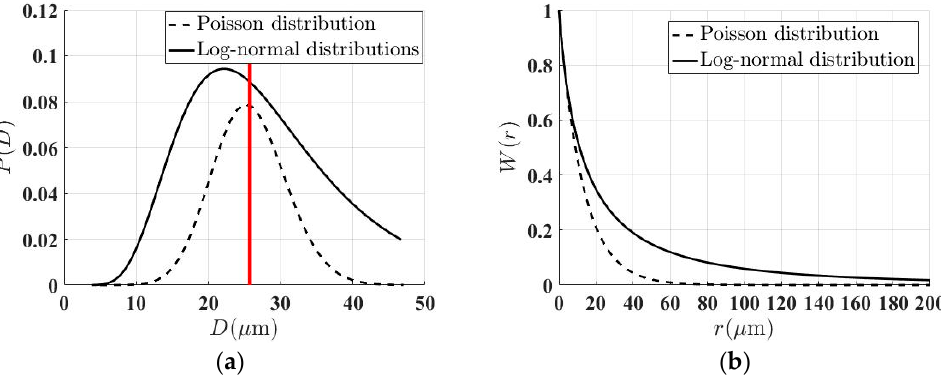
Figure 9. Comparison in ( a ) the probability density function of grain-size P ( D ) , and ( b ) the spatial correlation function W ( r ) between the assumed Poisson statistics in the classical model by Rokhlin and the log-normal distribution model fitted for the specimen holding for 0.5 h with a mean grain size of D = 26 µ m. (Color online).